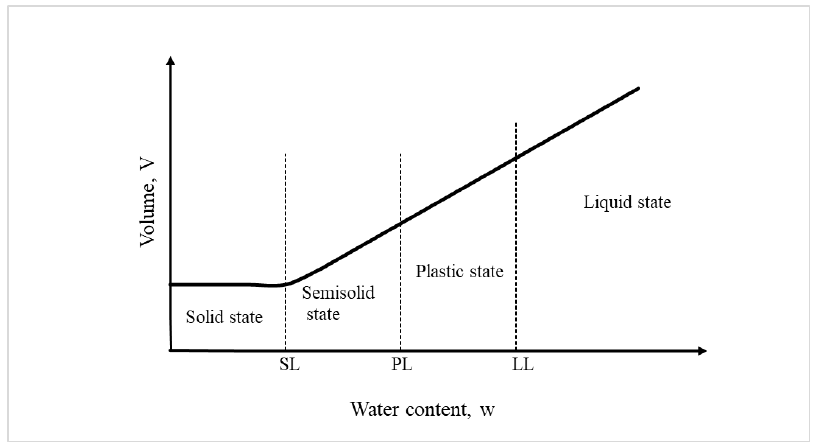
Figure 1. Consistency of cohesive soils [2].